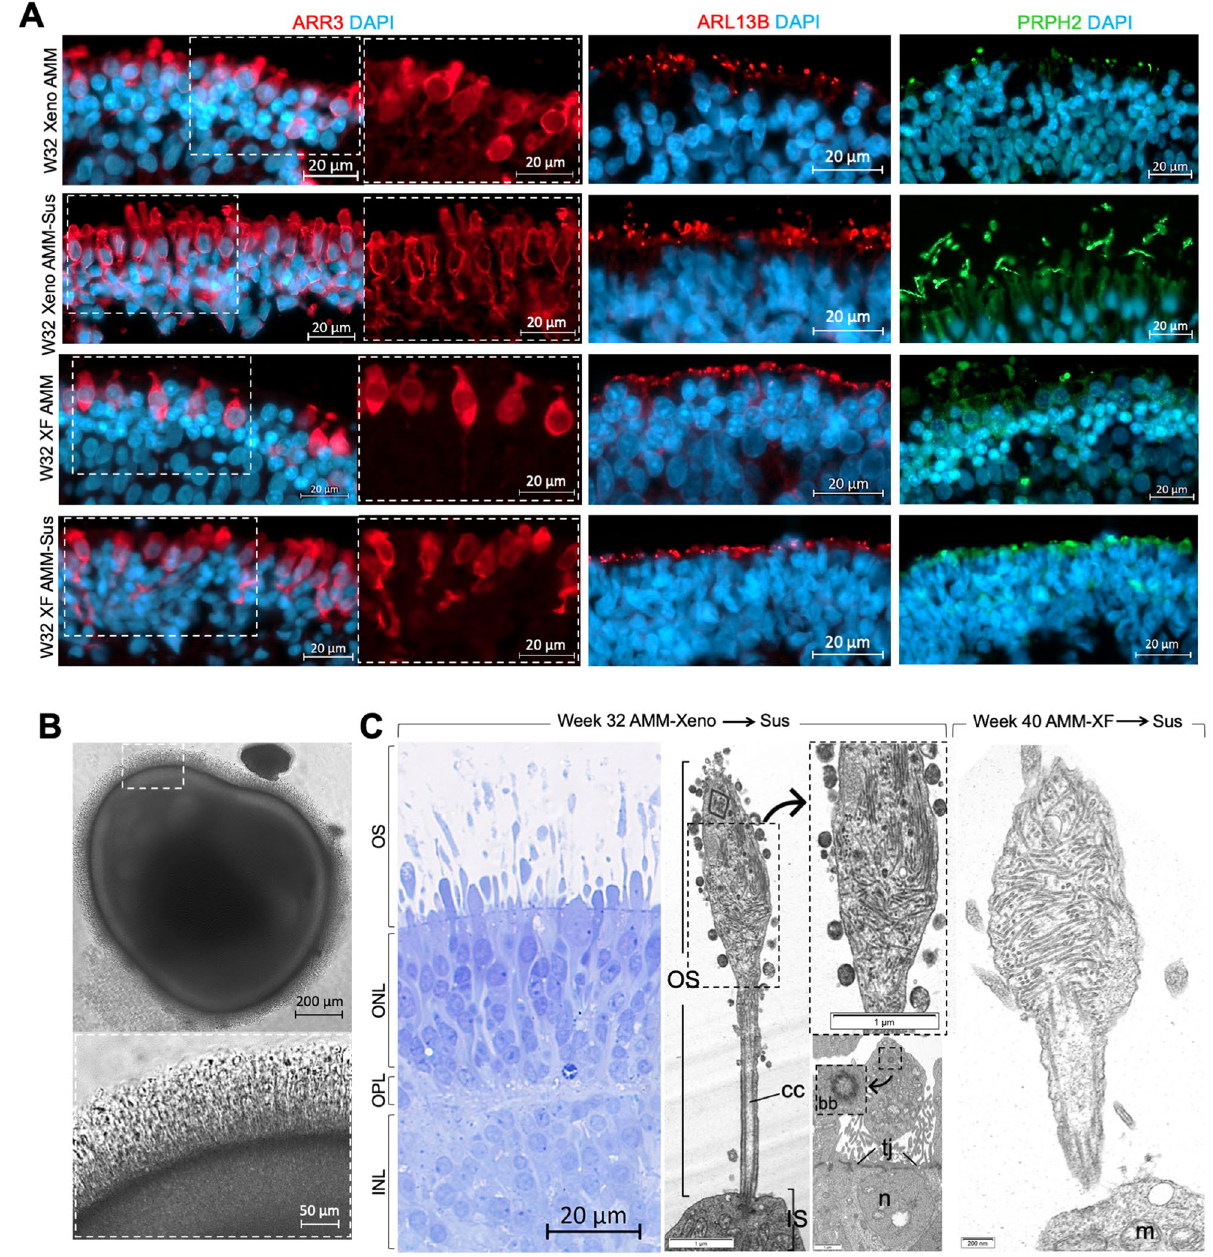
Figure 5. Formation of laminated retinal organoids with OS-like structures and expression of proteins associated with mature PRs. ( A ) Immunohistochemical staining of retinal organoids for ARR3, ARL13B, PRPH2 show morphological maturation and apical organisation of developing photoreceptor segment-like structures. Retinal organoids generated in AMMs using animal-derived supplements (xeno) or xeno-free (XF) conditions, transferred to suspension culture from day 60 of differentiation or maintained in AMMs showed immunostaining for cone outer segment protein ARR3. Retinal organoids matured in suspension in xeno conditions developed prominent OS-like structures labelling with ARR3, ARL13B or PRPH2. ( B ) Bright-field image of whole mount retinal organoid at week 32 of differentiation generated from MShef10 ESC line using AMMs and animal-derived supplements (xeno) and cultured in suspension; OS-like structures (arrowhead) developed from week 22–25 of differentiation. ( C ) IS, nascent OS, OLM, bb, cc and mt were detected in TEM images taken from ultrathin sections of week 32 retinal organoids (cultured in AMMs and grown in suspension under xeno conditions; n = 2) and of week 40 retinal organoids (AMMs in suspension under xeno-free conditions; n = 2) (MShef4 ESC line); cc, connecting cilia; OS, outer segment; IS, inner segment; bb, basal body; mt, mitochondria, OLM, outer limiting membrane, tj, tight